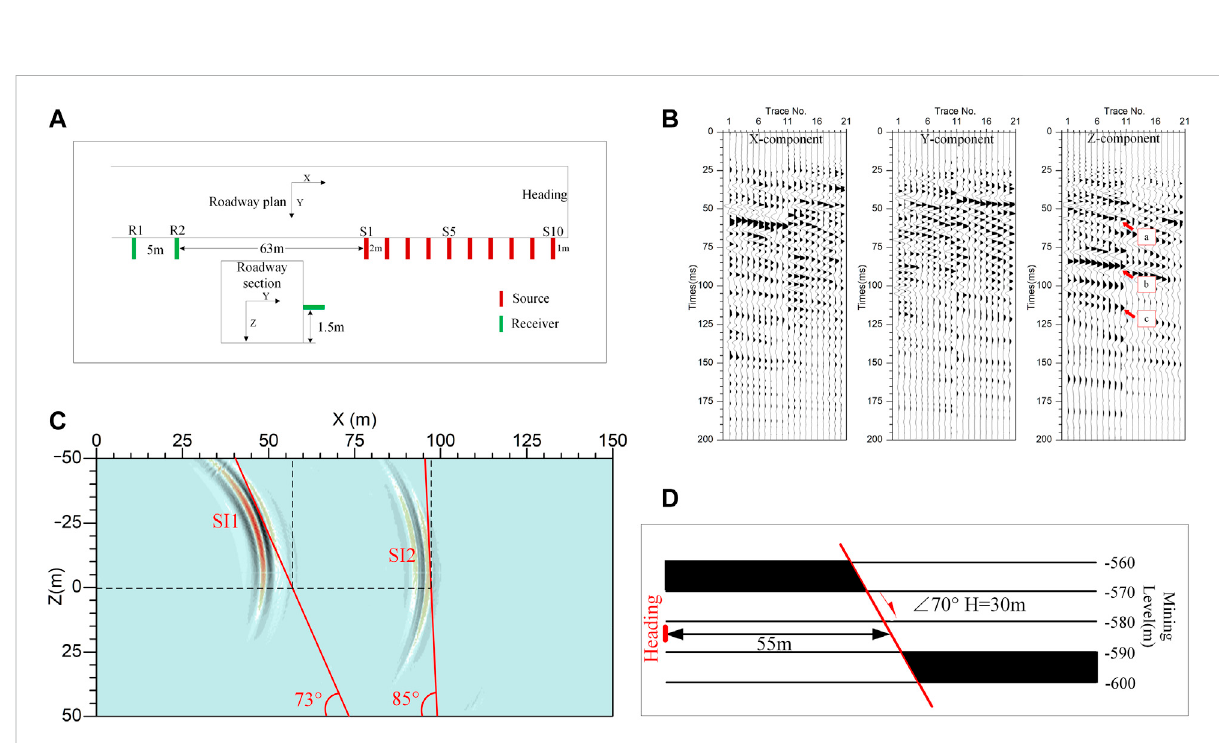
FIGURE 15 Field Study in Yilan Coal Mine. (A) Site layout. (B) Three-component records with τ -p transform. (C) Section of SV scattered waves in the fi eld study. (D) Geological section of the roadway in the fi eld study.